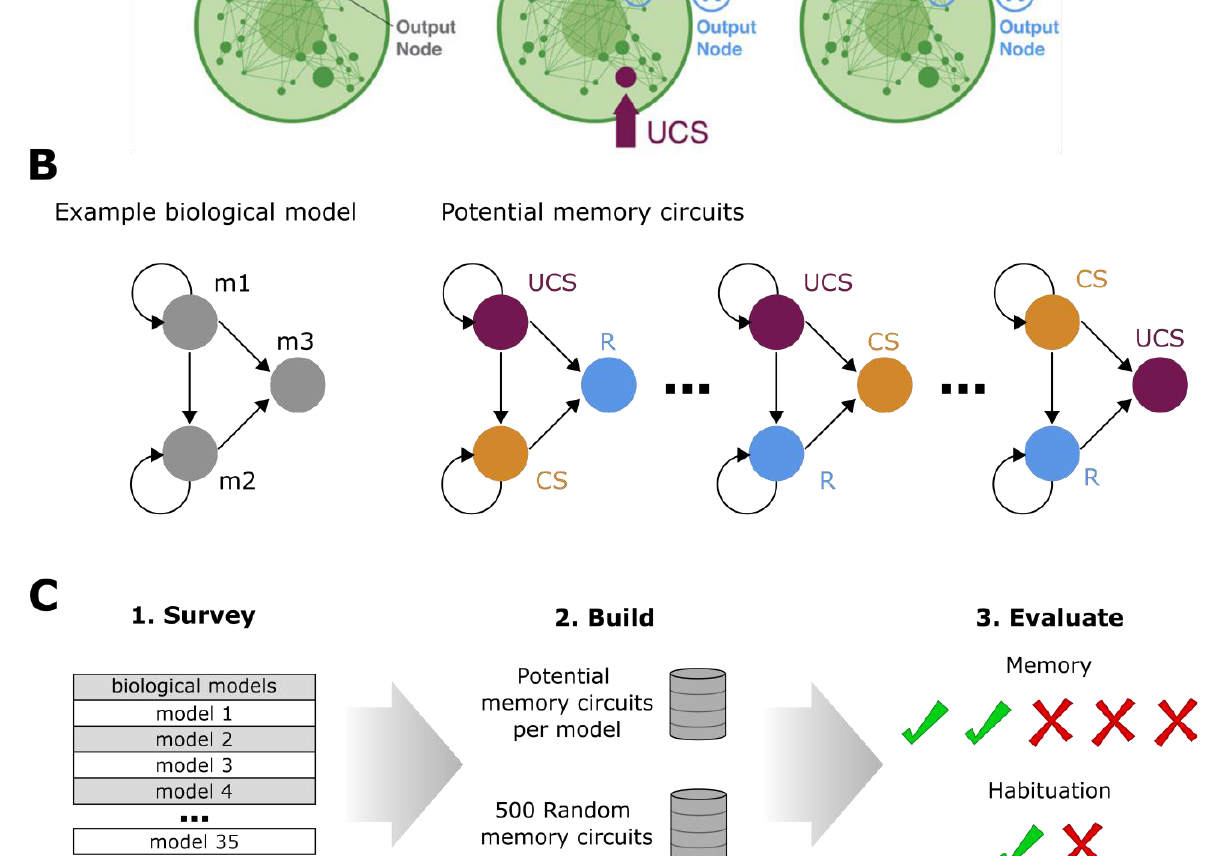
Figure 1. Conceptual approach and experimental design. ( A ) A cartoon representation of applying concepts from behavioral science, such as classical conditioning, towards controlling a biological network. Knowledge is not needed of how a dog’s brain changes during the training session that pairs the sound of a bell (stimulus) to a drooling response, but it is possible to form such a memory. In the same way, we need not understand the intricacies of a biological network in order to train a stimulus to a response. ( B ) Given a biological network model, such as the example on the far right, potential memory circuits are built that test the model with every possible pairing of stimulus (UCS, violet), response (R, blue), and potential conditioned stimulus (CS, yellow). The number of potential memory circuits is therefore the number permutations of N nodes with three choices (i.e., six in this cartoon). ( C ) Cartoon of analytical pipeline. Thirty-five biological models are used to build both potential memory circuits as well as 500 random networks. All networks are tested for memory, habituation, and sensitization (not shown). ( A ) is adapted from [67], with permission.